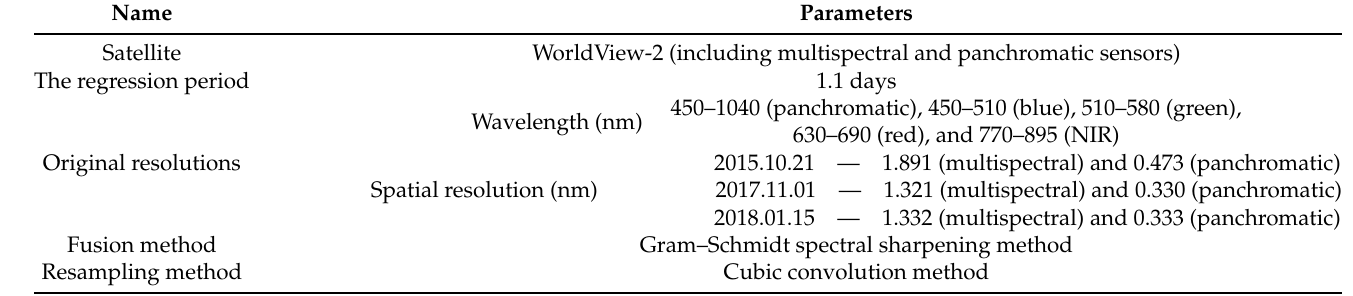
Table 3. Detailed parameters of the used data.